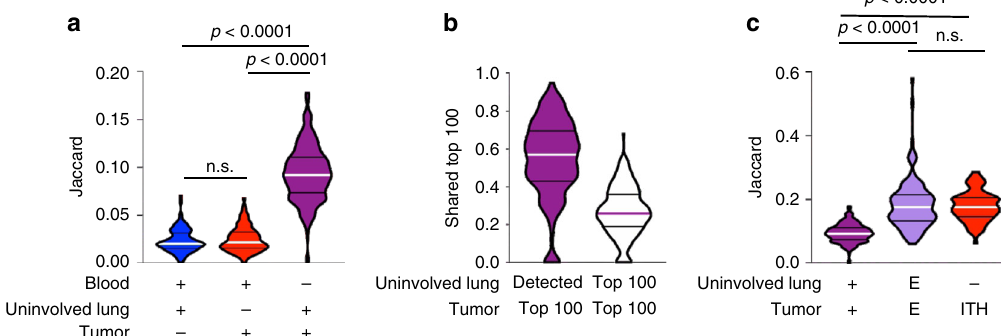
Fig. 6 T cell repertoire overlap between adjacent uninvolved lung and tumor. a Jaccard Index when comparing PBMC, uninvolved tumor-adjacent lung, and tumor T cell repertoires ( n = 215). b Proportion of the top 100 T cells in the tumor shared with the uninvolved tumor-adjacent lung ( n = 225). c Jaccard Index in the T cell repertoire when comparing the tumor-adjacent uninvolved lung to tumors, lung-enriched ( e ) T cell repertoire between the tumor- adjacent uninvolved lung and tumor, and different regions of the same tumor (ITH) ( n = 215). Bars represent median and